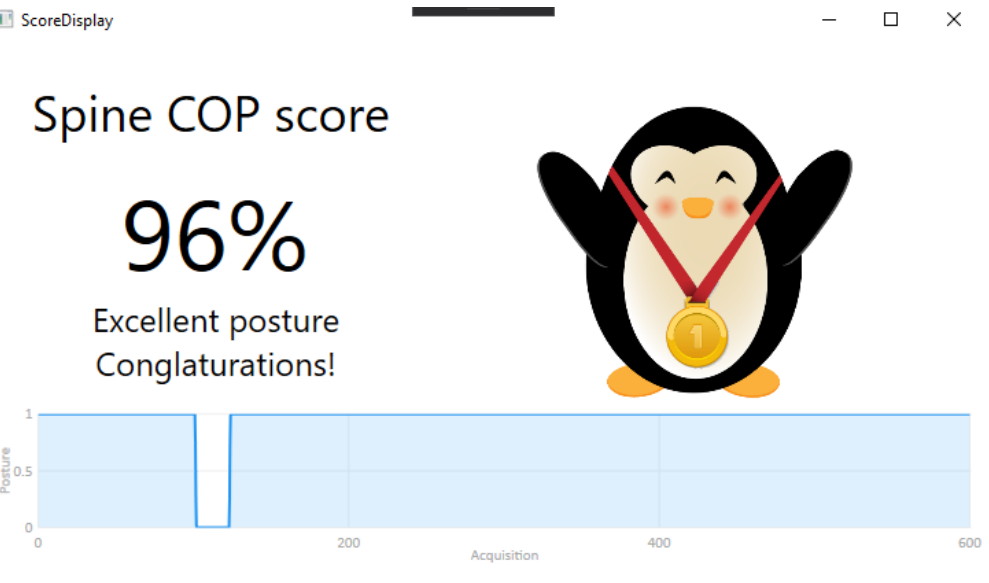
Figure 5. Posture classification over a 2 min period. In this case, the user performed the correct posture for 96% of the test